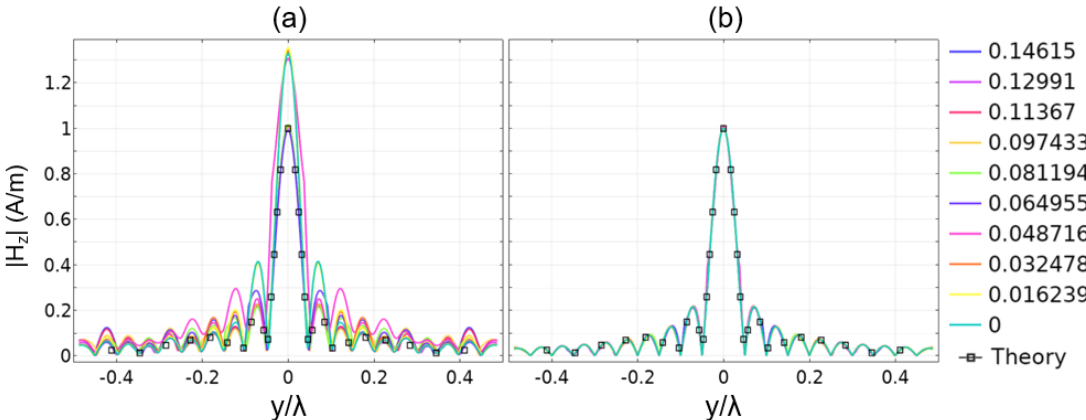
Figure 6. Profile of the magnetic field in the focal plane for a variety of separation distances for the geometry in Figure 5. ( a ) Without correcting for the contribution of the dielectrics and ( b ) correcting for the full domain with the constraint imposed in the FEM